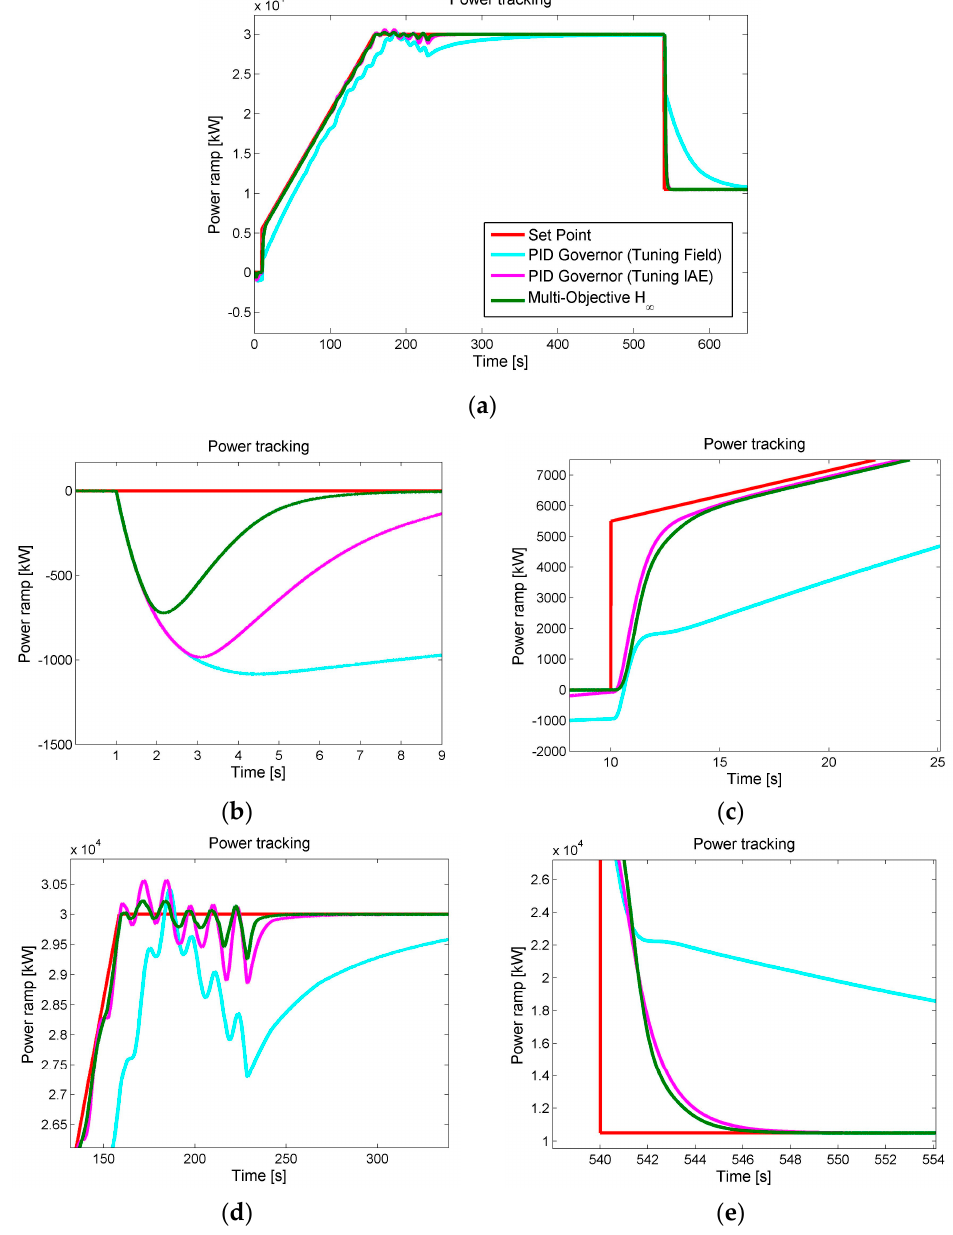
Figure 23. Closed-loop power reference tracking of the perturbed nonlinear system. Comparison between the multi-objective H ∞ robust controller and the PID Governor tuned with IAE settings and site settings: ( a ) Complete view; ( b ) Disturbance rejection in the initial stage; ( c ) Ramp command start; ( d ) Steady-state at 30 MW; ( e ) Power profile in the final stage.